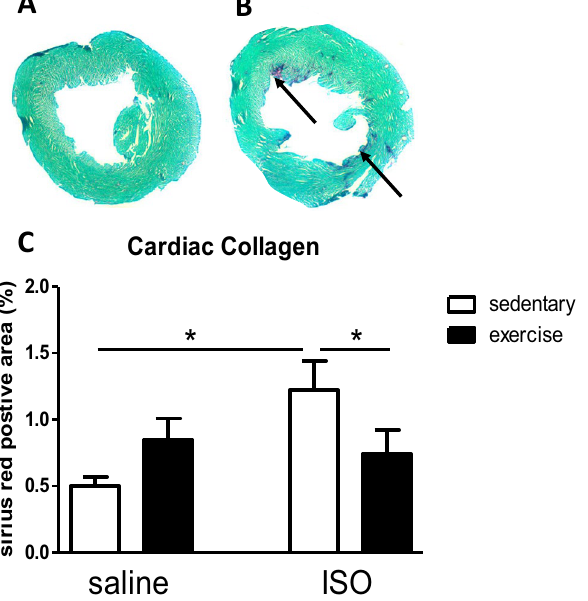
Figure 1. ( A ) and ( B ): typical pictures of sections of the left ventricle, stained for collagen with Sirius red (purple) and fast green as counterstaining. ( A ) section of a saline sedentary rat; ( B ): section of an ISO treated sedentary rats. Arrows point to areas with increased collagen. ( C ): Measured percentage of collagen in the left ventricle as Sirius Red positive area, at mid-ventricular level, in saline or isoproterenol (ISO) treated rats, under sedentary conditions or after five weeks of exercise training (n = 10, 10, 10, 9 for saline sedentary, saline exercise, ISO sedentary and ISO exercise rats, respectively). *: significant difference between groups ( p <